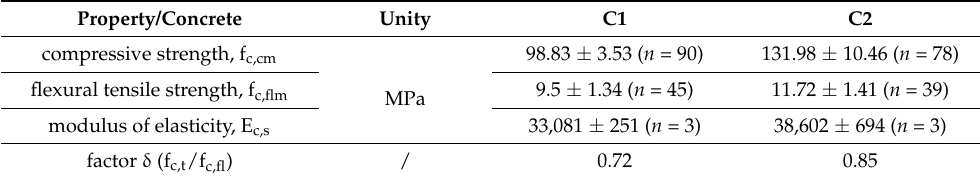
Table 2. Properties of the fine-grained concrete according to EN 196 [24] and EN 12390-13 [25], n = number of results, ± standard